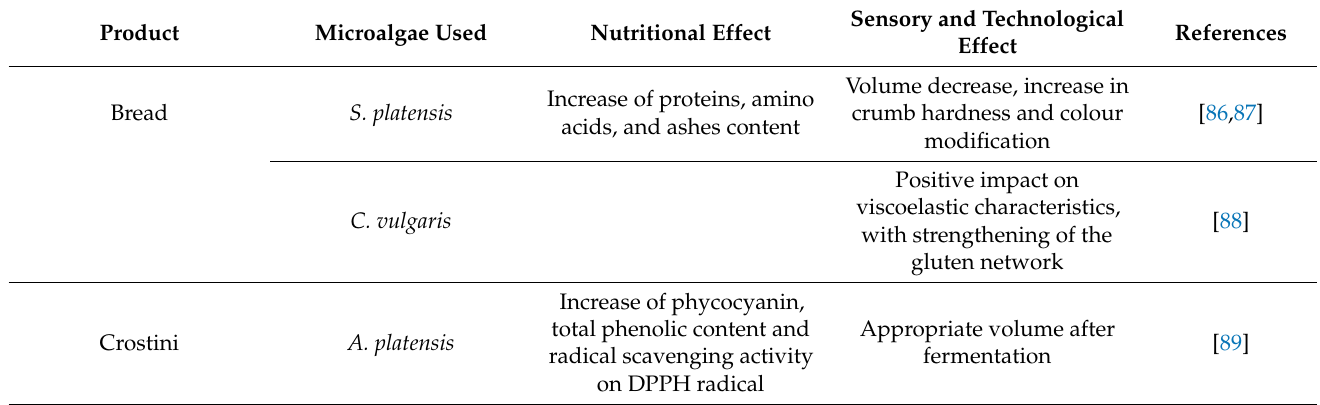
Table 2. Main nutritional, sensory, and technological effects of microalgae fortification in